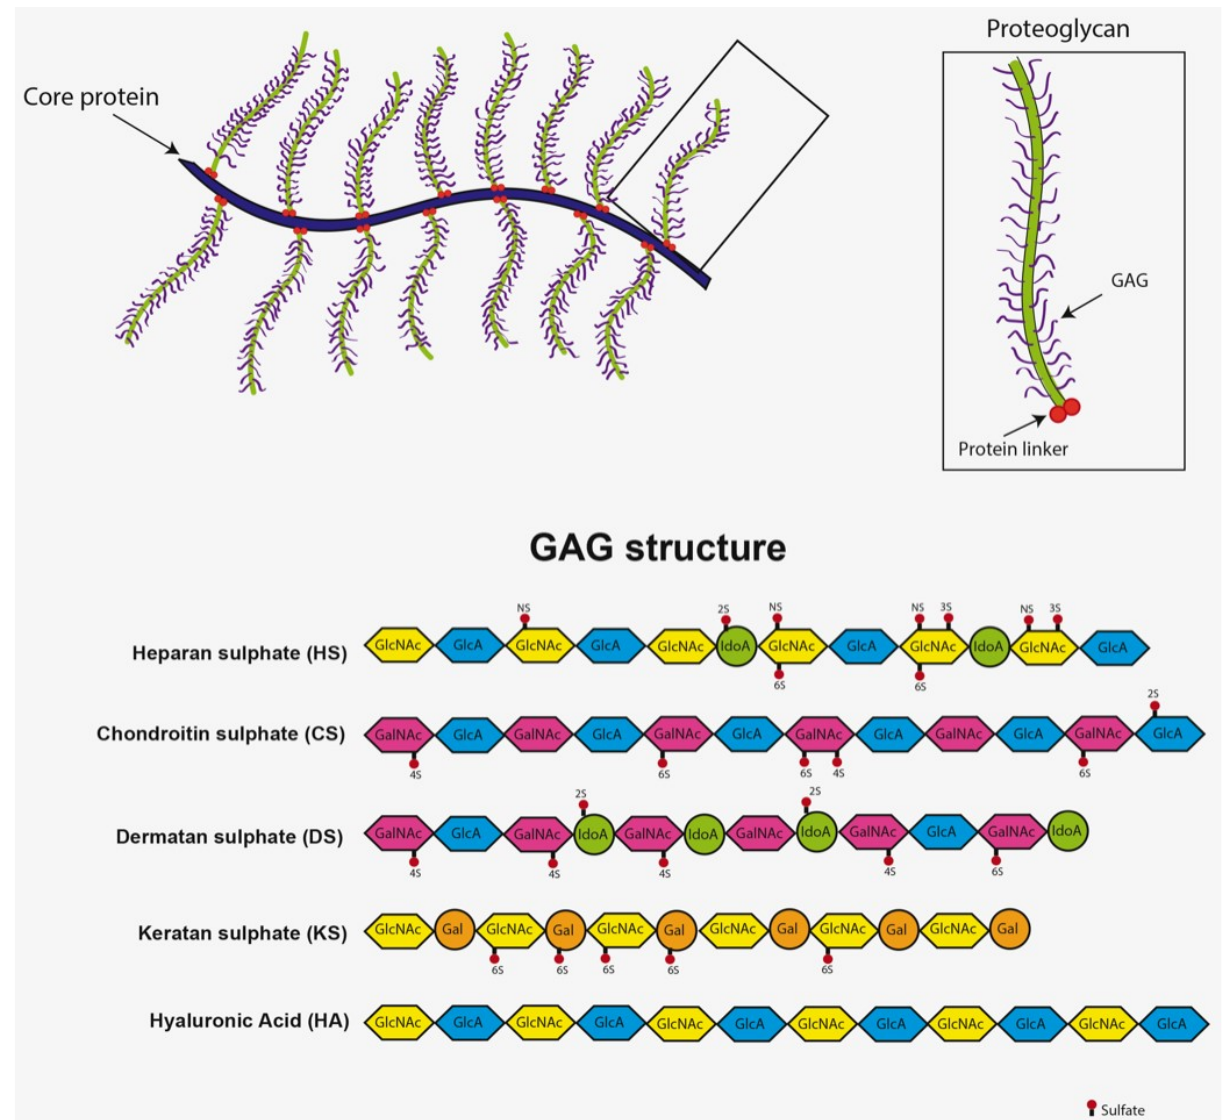
Figure 2. Schematic representation of a proteoglycan ( top ) and structure of principal GAG chains ( bottom ).